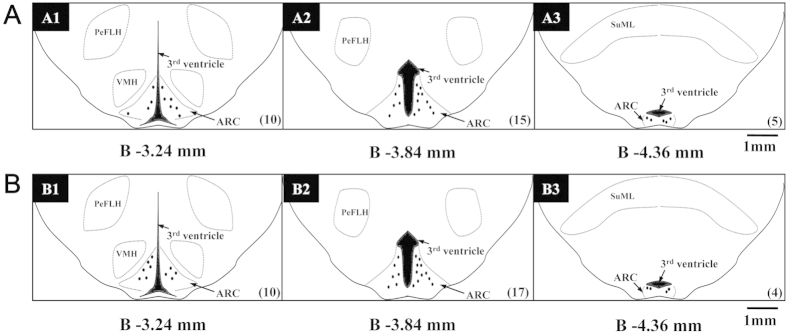
Histological verification of recorded PENs in the ARC.The standard diagrams show coronal sections at three levels posterior to Bregma (A1, B1: −3.3 mm; A2, B2: −3.8 mm; A3, B3: −4.3 mm). Coronal sections are based on atlas plates from Paxinos and Watson (1998). Symbols (black dots) show the positions of the tip of the microelectrophoresis probe in the ARC. (A) In representative coronal sections, recorded PENs (n = 30) in the ARC from control rats are indicated. (B) In representative coronal sections, recorded PENs (n = 31) in the ARC from CFA rats are indicated. ARC: arcuate nucleus; 3 V: 3rd ventricle. The numbers in parentheses under each figure indicate the number of neurons recorded in the ARC.